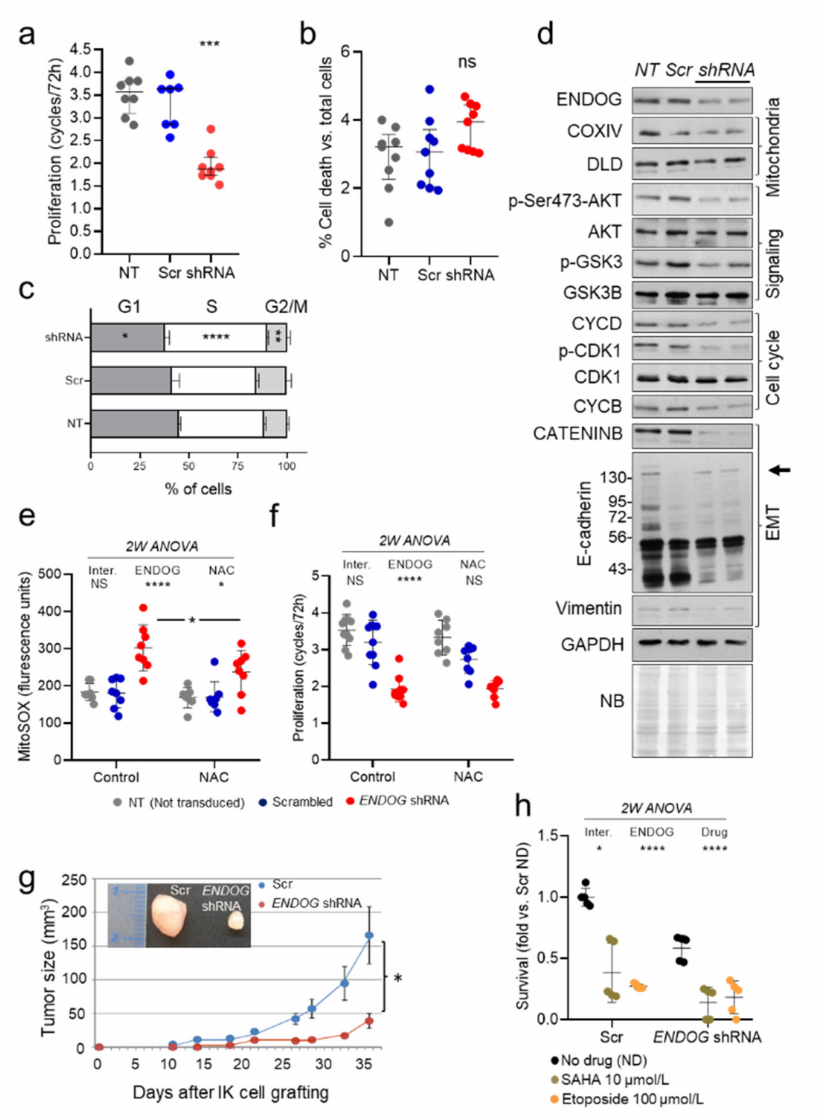
Figure 1. ENDOG silencing reduces proliferation in the Ishikawa endometrial carcinoma cell line in association with increased ROS production and reduced AKT-GSK-3 activation, hindering tumor